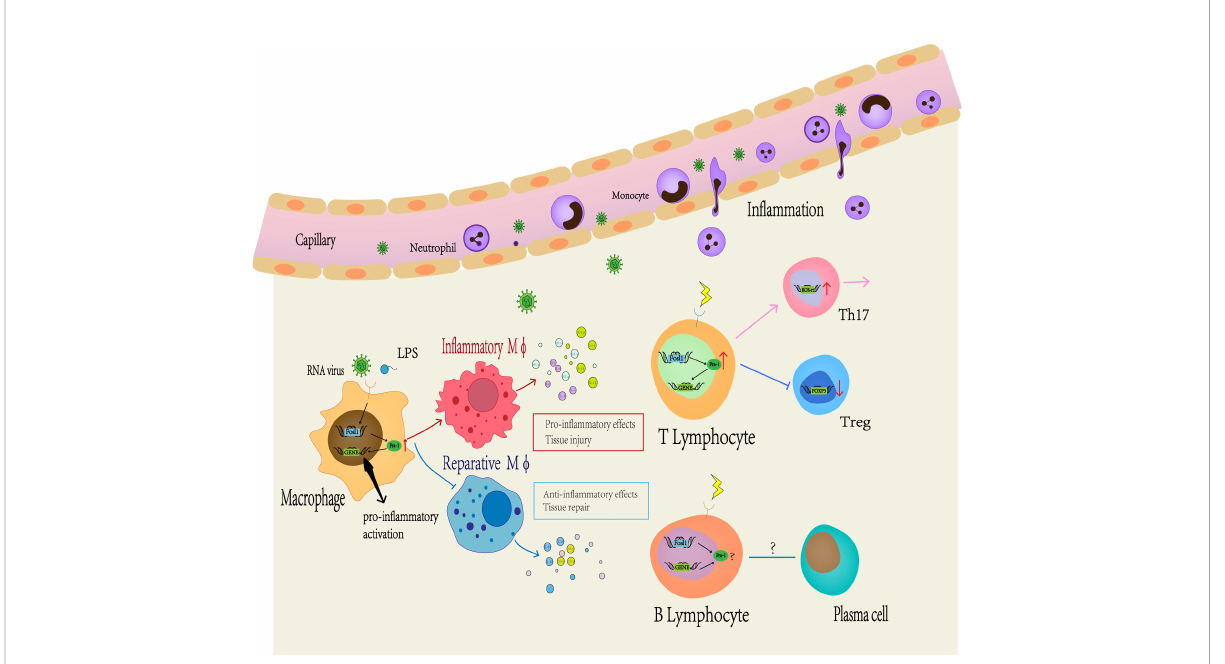
FIGURE 3 Fra-1mediated immune regulation. A large number ofstudies have shown that Fra-1regulates the function and activity of various immune cells in vivo . At fi rst, the expressionlevel ofFra-1 affects the migrationof neutrophils, the differentiationof macrophages and T or B lymphocyte. When the body is infected or stimulated, the expression levelof Fra-1in immune cells increases, prompting moreneutrophils to migrate frombloodvessels to the site of in fl ammation, promoting M0 macrophages to differentiate moreinto M1-type macrophages and secrete morerelated pro-in fl ammatory cytokines. In addition, Fra-1has beenreported to be the coreof T orB lymphocyte differention in the adaptive immune